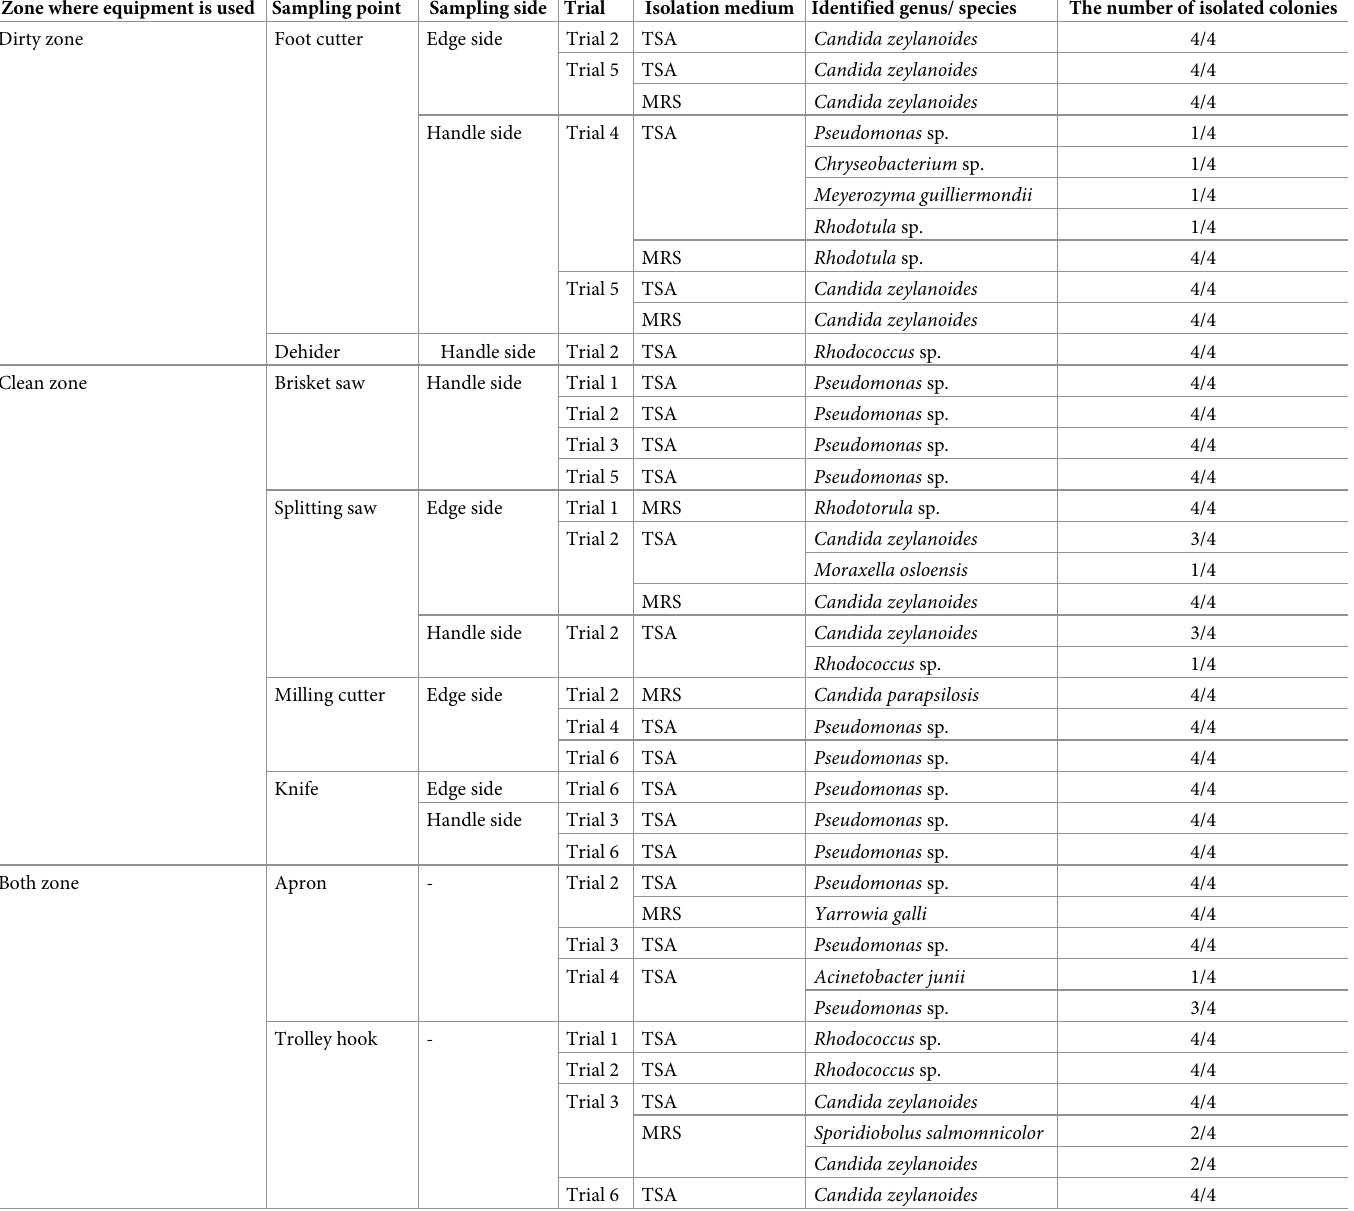
Table 3. Identification results of psychrophilic microorganisms adhering to equipment used in slaughtering line. Zone where equipment is used Sampling